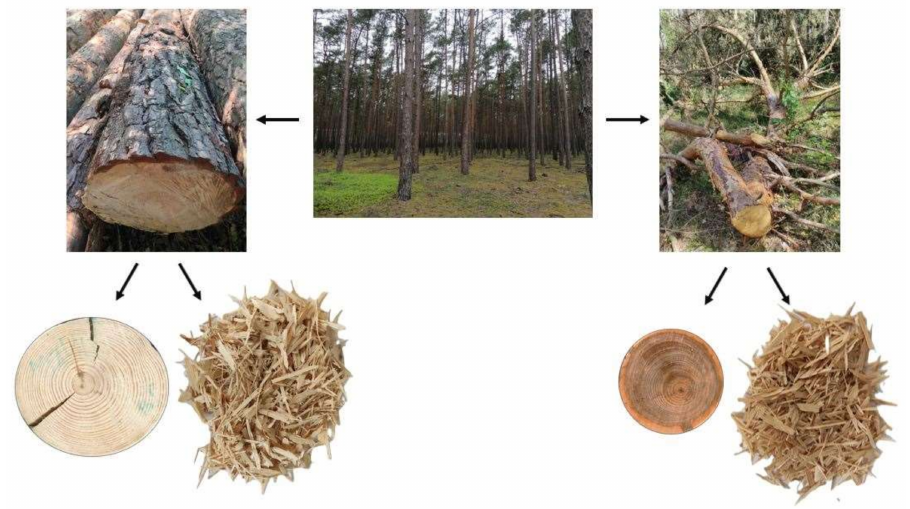
Figure 1. The process of obtaining individual elements of raw materials. A 1.0 m long log was taken from each tree, measured from the base of the trunk, and pieces of branches were cut from each crown. Immediately after the tree was cut, approximately 4 cm thick discs were cut at the breast height from each tree for green (GD) and basic (BD) density estimation. Respectively the same was done with branches. Each disc was weighed with an accuracy of 0.001 g using a Steinberg laboratory scale (Steinberg Systems SBS-LW-200A, Berlin, Germany). After weighing, the thickness of each sample was measured to an accuracy of 0.01 mm using a certified Vogel calliper in five different places, and the diameter of each disc was measured by using the cross-over method according to the minimum and maximum size of the sample (Vogel Germany GmbH & Co. KG, Kevelaer, Germany). Then, the volume of each disc was calculated by Equation (1) according to P é rez-Harguindeguy et al. dimensional methodology